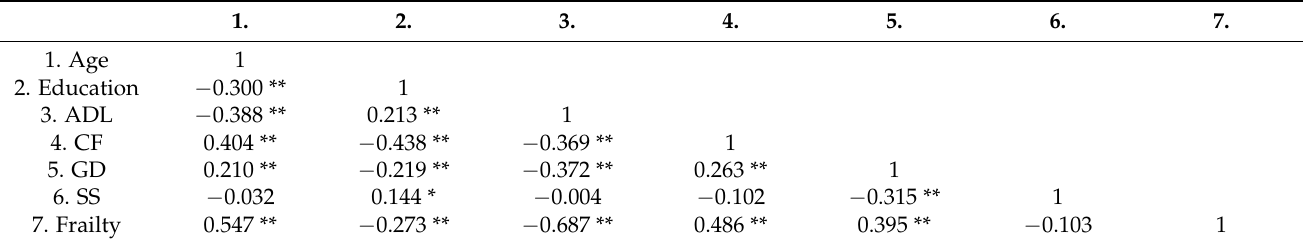
Table 2. Degree of frailty related to age, education level, activities of daily living, cognitive function, depression, and social support ( n =